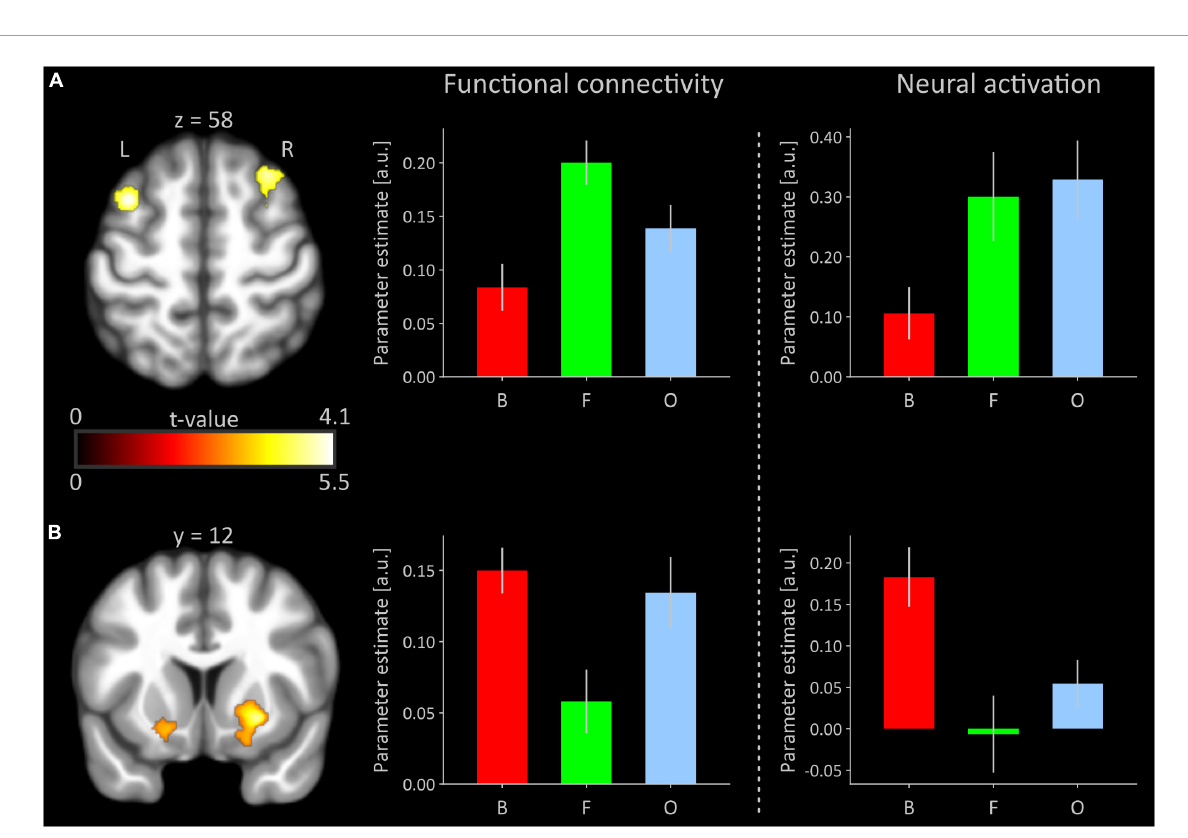
FIGURE2 (A) Significant inverted U-shaped (invU) connectivity changes of prefrontal cortical regions with the right anterior insular seed. Clusters are overlaid on a transversal section obtained from participants’ MNI-normalized and averaged T1 images ( N = 41) using MRIcroGL (Rorden and Brett, 2000). The bar graph in the middle depicts the cluster-averaged height of functional connectivity for the left dorsolateral prefrontal cluster (comprised of parts of the middle and inferior frontal gyri; cluster size: 462 voxels) for conditions of boredom (B), flow (F), and overload (O). The rightmost bar graph shows un-thresholded, estimated neural activation for each of the three experimental conditions, averaged across all voxels of the left dorsolateral prefrontal cortex that were significant in the functional connectivity analysis. (B) Significant U-shaped connectivity changes of ventral striatal regions with the right anterior insular seed. The bar graphs depict functional connectivity and neural activation, respectively, for the right putamen (250 voxels). The bar graph under neural activation shows again un-thresholded, estimated neural activation for each of the three conditions, averaged across all voxels of right putamen, significant in the functional connectivity analysis. Error bars refer to the standard error of mean. a.u., arbitrary unit; L, left; R, right. Averaged results for the right middle/superior frontal gyri and left putamen (see Table 1 ) in terms of functional connectivity and neural activation are presented in Supplementary Figure 1